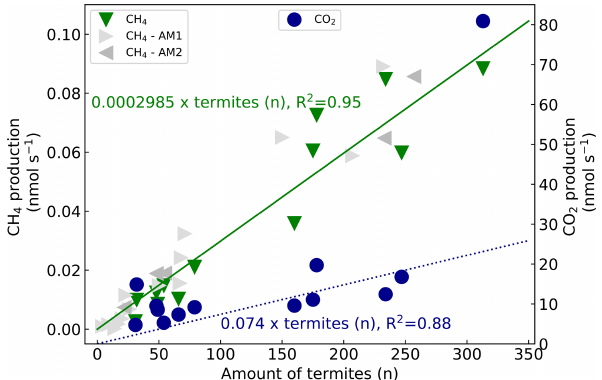
Figure 4. CH 4 production (left axis, green triangles) and CO 2 pro- duction (right axis, blue circles) over counted termites. The lines (green solid for CH 4 , blue dashed for CO 2 ) represent a linear re- gression fit with forced intercept at y = 0. For CH 4 , a production of 0.0002985nmoltermite − 1 s − 1 (se = 1 . 77 × 10 − 5 , R 2 = 0 . 95) was found and, for CO 2 , a production of 0.1316nmoltermite − 1 s − 1 (se = 2 . 59 × 10 − 2 , R 2 = 0 . 68) was found. Excluding the outliers (32, 14.9nmols − 1 & 313, 80.9nmols − 1 ) gives an R 2 of 0.88 ( n = 11) with a CO 2 emission of 0.074nmoltermite − 1 s − 1 (se = 8 . 5 × 10 − 3 ). For comparison, two sets of additional subsample CH 4 emis- sion measurements are shown. The first additional measurements (AM1, light grey triangles) resulted in a termite emission factor of 0.0002976nmoltermite − 1 s − 1 (se = 1 . 32 × 10 − 5 ) (one measure- ment point (599 termites, 0.165nmols − 1 ) is not shown in this fig- ure). The second set (AM2, dark grey triangles) gave a termite emis- sion factor of 0.0003043nmoltermite − 1 s − 1 (se = 1 . 41 × 10 − 5